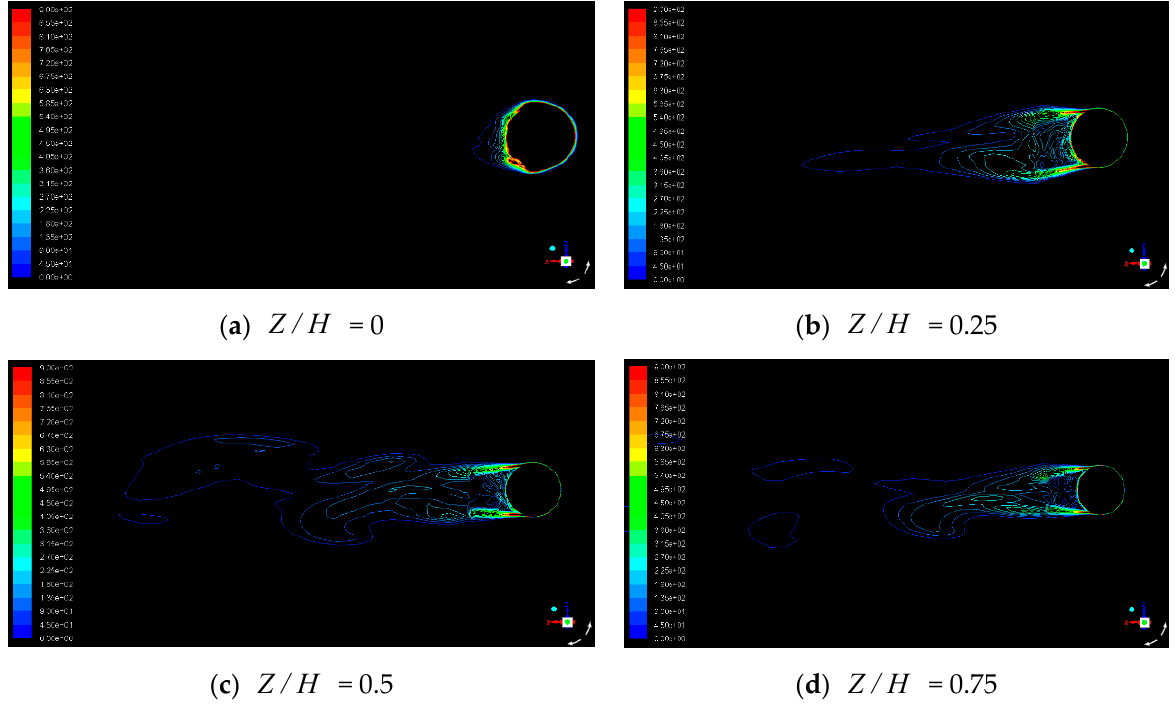
Figure 14. Contour lines of vorticity in the horizontal plane at H / D = 5: ( a ) Z / H = 0; ( b ) Z / H = 0.25; ( c ) Z / H = 0.5 and ( d ) Z / H = 0.75.